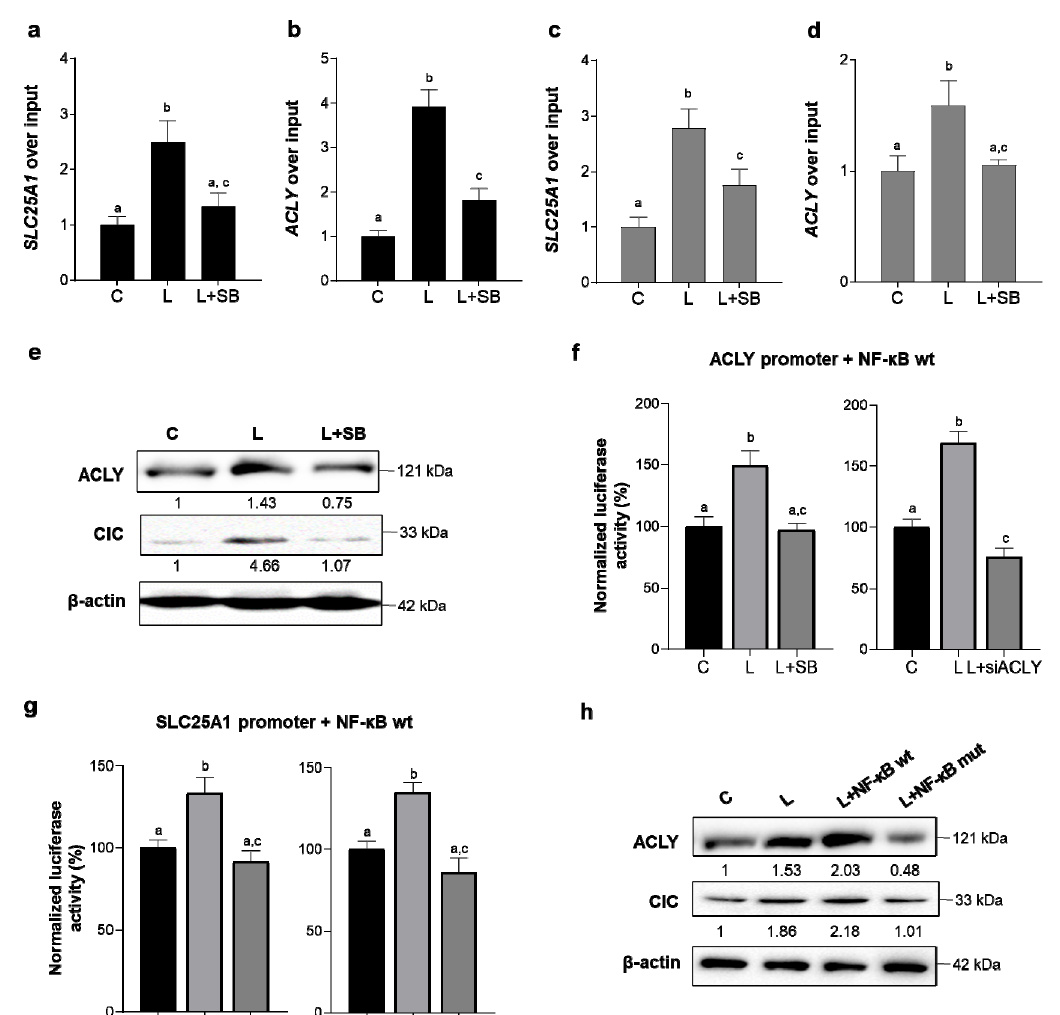
Figure 5. ACLY-mediated NF- κ B full activation upregulated the SLC25A1 and ACLY genes. Human PBMC-derived macrophages were triggered by LPS in the presence or absence of SB, and ( a , b ) were used to carry out chromatin im- munoprecipitation (ChIP) analysis with an antibody against subunit p65 of NF- κ B. Then, specific primers were used in real-time PCR experiments to analyze the SLC25A1 and ACLY gene promoters. ( c , d ) Human PBMC-derived